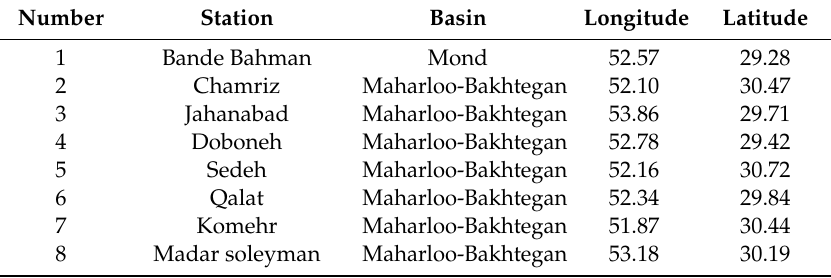
Figure A5. Trend of flow in selected rivers across the study area (1997–2016). The Kor, Firouzabad, and Mond rivers had more than one selected station, so station names are added. Neg. and Pos. are negative and positive trend. Regions: W: western, NW: northwestern, C: central, S: southern, E: eastern, and NE: northeastern. SL = significance level. Detailed information on all stations is available in Table A2. Table A1. Information on meteorological stations that supplied precipitation and temperature data .